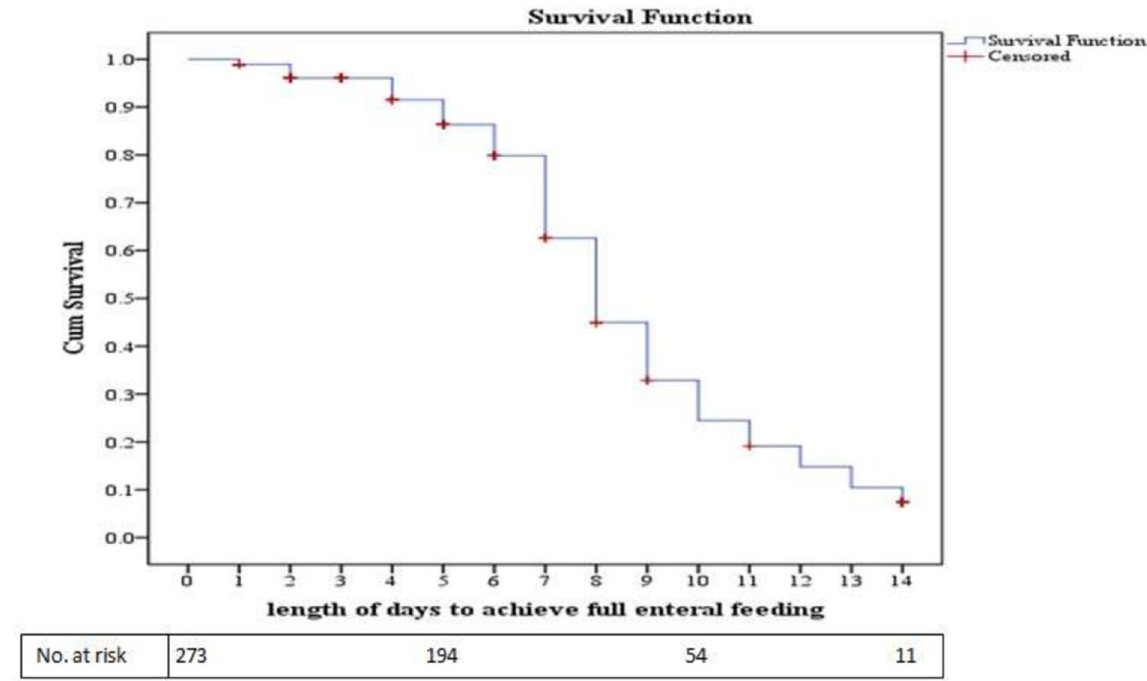
Fig 3. Kaplan-Meier survival function curve of full enteral feeding achievement for neonates admitted to the neonatal ICU.